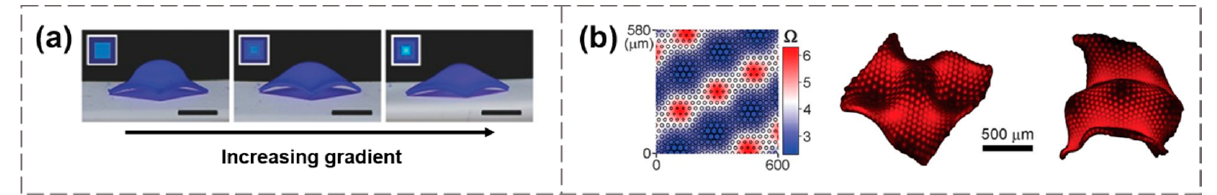
Figure 2. Programming the shape-morphing using in-plane material gradients. ( a ) The cap geometry controlled by increasing gradient distribution. Reproduced from Ref. [71]; ( b ) Multi-stable configurations of a continuous swelling pattern through secondary crosslinking. Reproduced from Ref. [74].